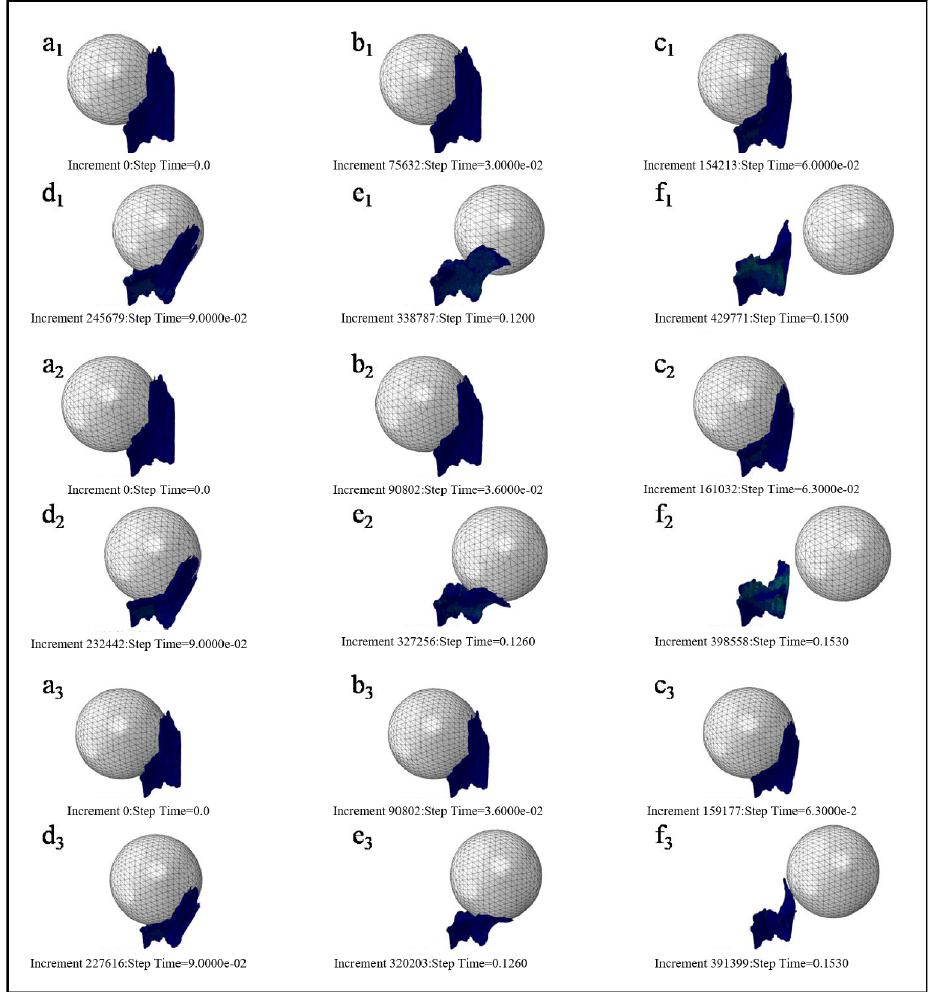
Figure 5. Motion status of three kinds of fetal head models at the different simulation time. (a to f refer to the motion status of 3 kinds of fetal head models (Models D80, D90, and D100 in order) at simulation time of 0s, 0.03s, 0.06s, 0.09s, 0.12s, and 0.15s)